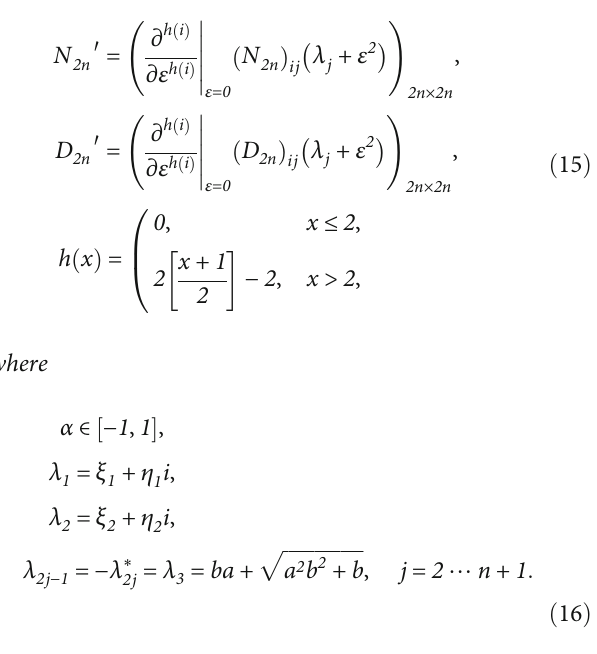
ffiffiffi p 3 /2 . Color